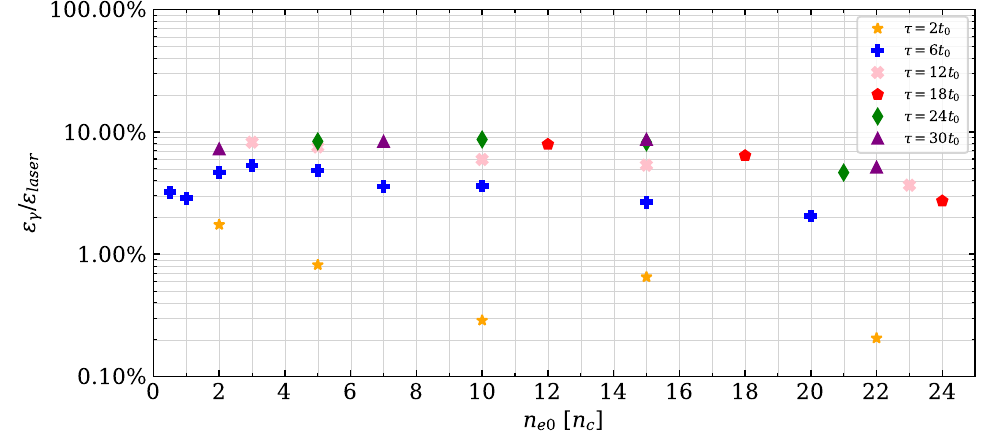
Figure 11. Absorption coefficient from the laser pulse to high energy photons at the optimum target thickness vs. target density for different laser pulse durations. Target parameters: L y = 30 µ m. Laser parameters: λ = 1 µ m, a 0 = 85 and w 0 = 12.5 µ